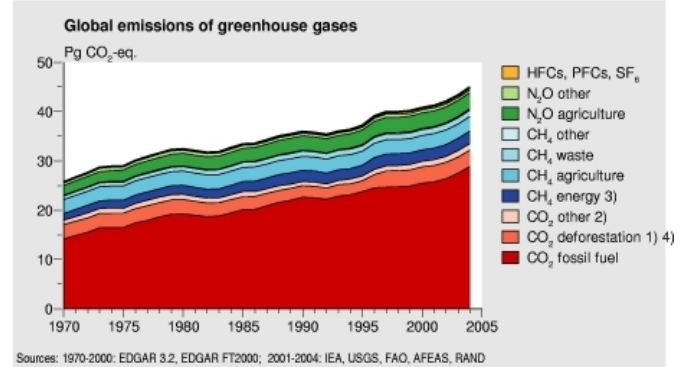
Figure 2. Global greenhouse (GHG) gas emissions.